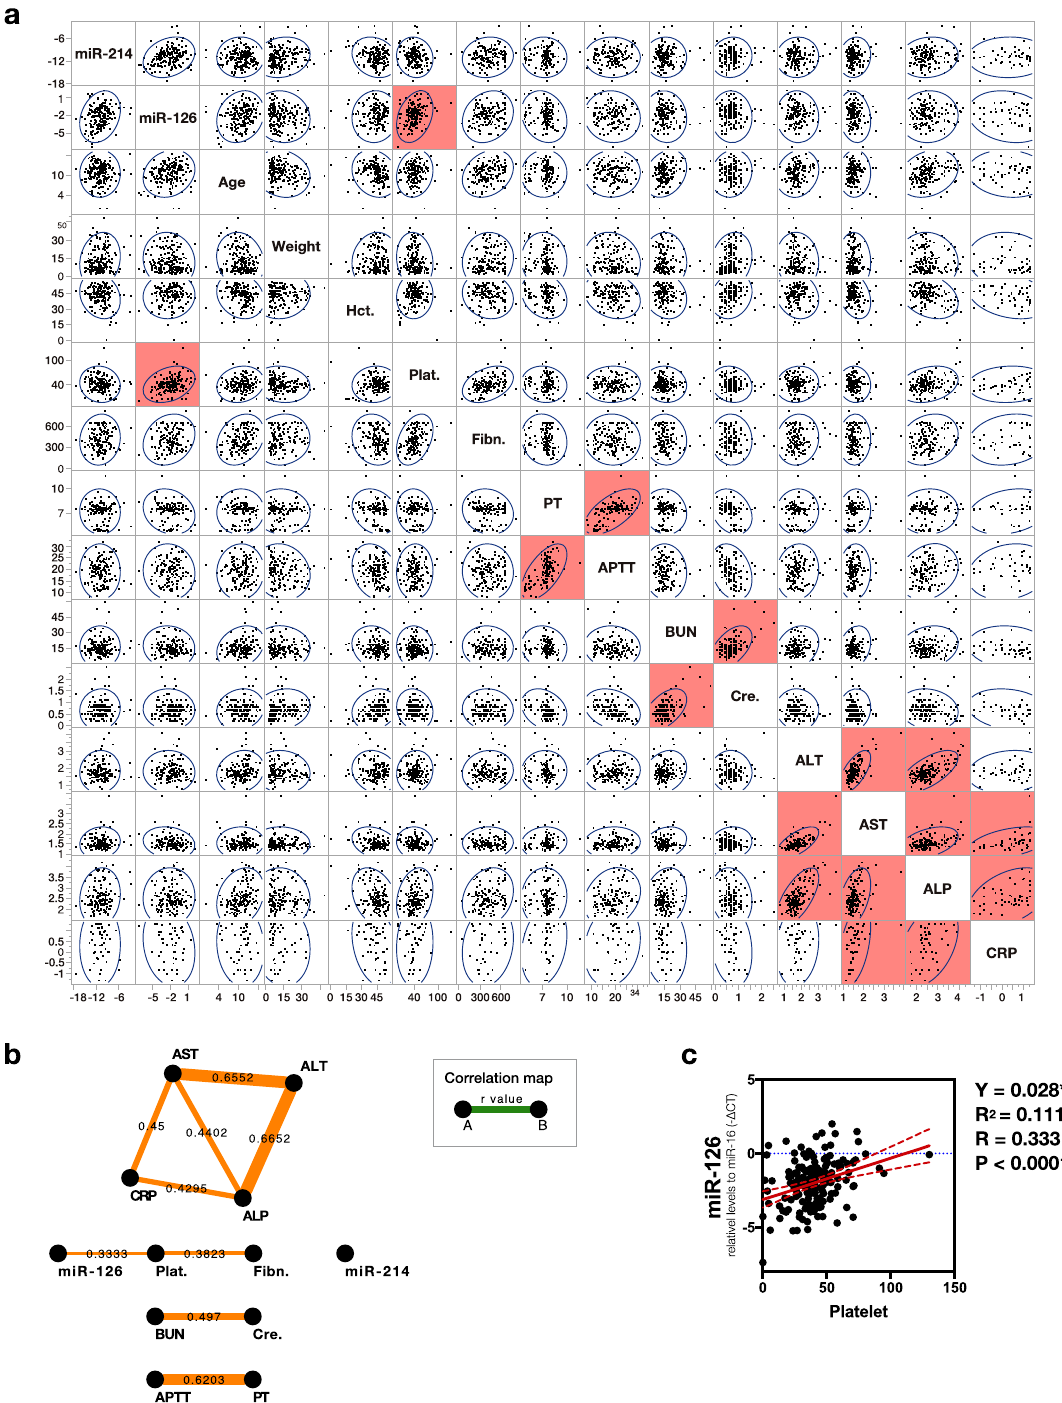
Figure 7. Correlation analysis between the circulating miR-214, -126 levels, and various clinical parameters. Circulating miR-214 and -126 levels did not show a strong correlation with the other clinical parameters. (a) Multivariate correlation analysis using scatter plots for circulating miR-214, -126 levels, age, weight, Hct., Plat., Fibn., PT, APTT, BUN, Cre., ALT, AST, ALP, and CRP. Blue circles indicate trends of scatter points. Areas given in red indicate that the 2 parameters show a significant correlation (P < 0.05, Pearson product-moment correlation coefficient). (b) Map for correlation between the parameters. The correlations between parameters connected to each other with bands are indicated. R-values are displayed in the centre between 2 parameters, and band thickness represents the degree of correlation. R-values only with statistical significance are illustrated on the map. (c) Linear regression analysis for platelet counts and circulating miR-126 levels. P-value was calculated based on the null hypothesis that the slope of the regression curve is